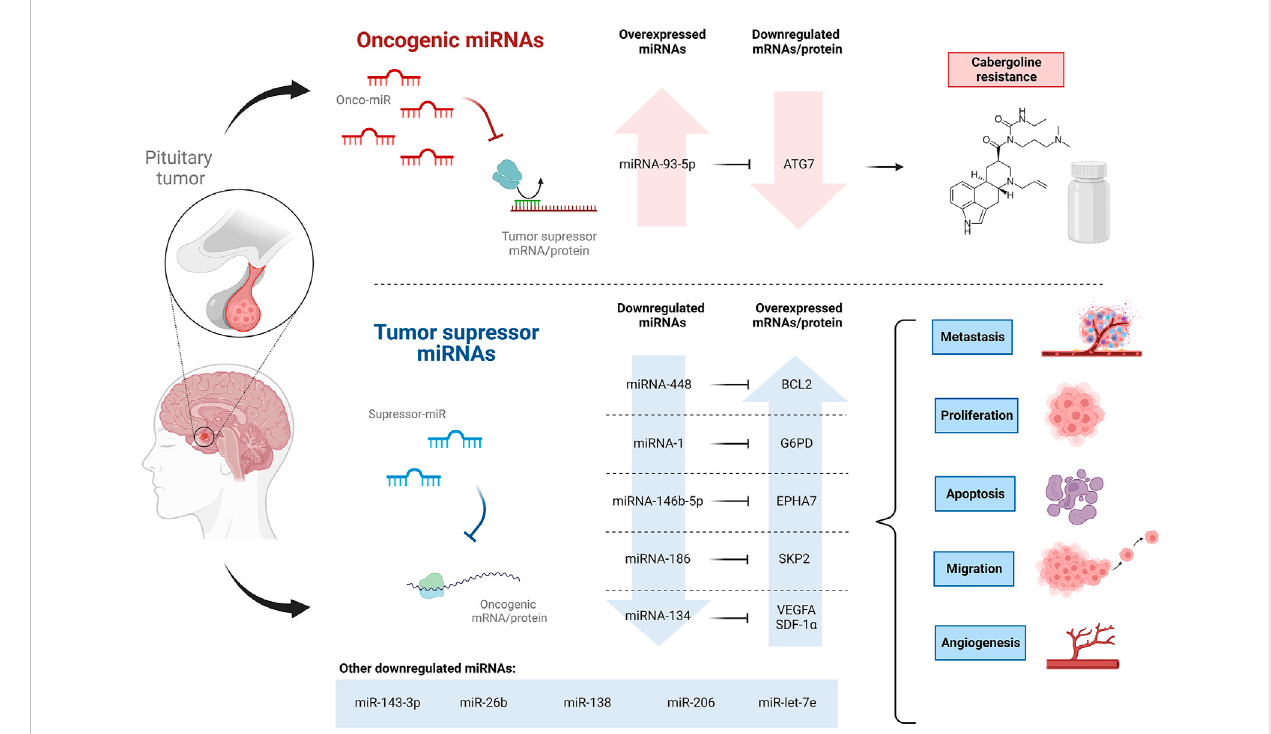
Oncogenic and tumor suppressor miRNAs expression pro fi le involved in pituitary tumors, ultimately affecting cabergoline resistance, proliferation, metastasis, apoptosis, and